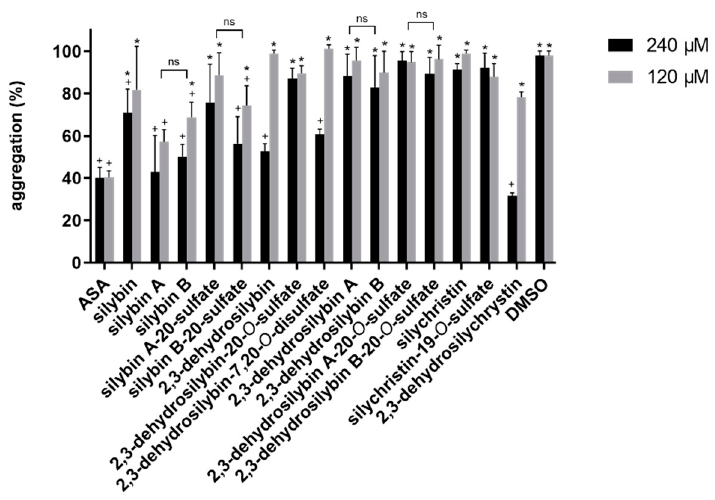
Figure 5. Effect of flavonolignans on whole-blood platelet aggregation induced by collagen. Data are expressed as mean ± SD. * p <0.05 vs. acetylsalicylic acid (ASA); + p <0.05 vs. solvent (DMSO); ns: non-significant.